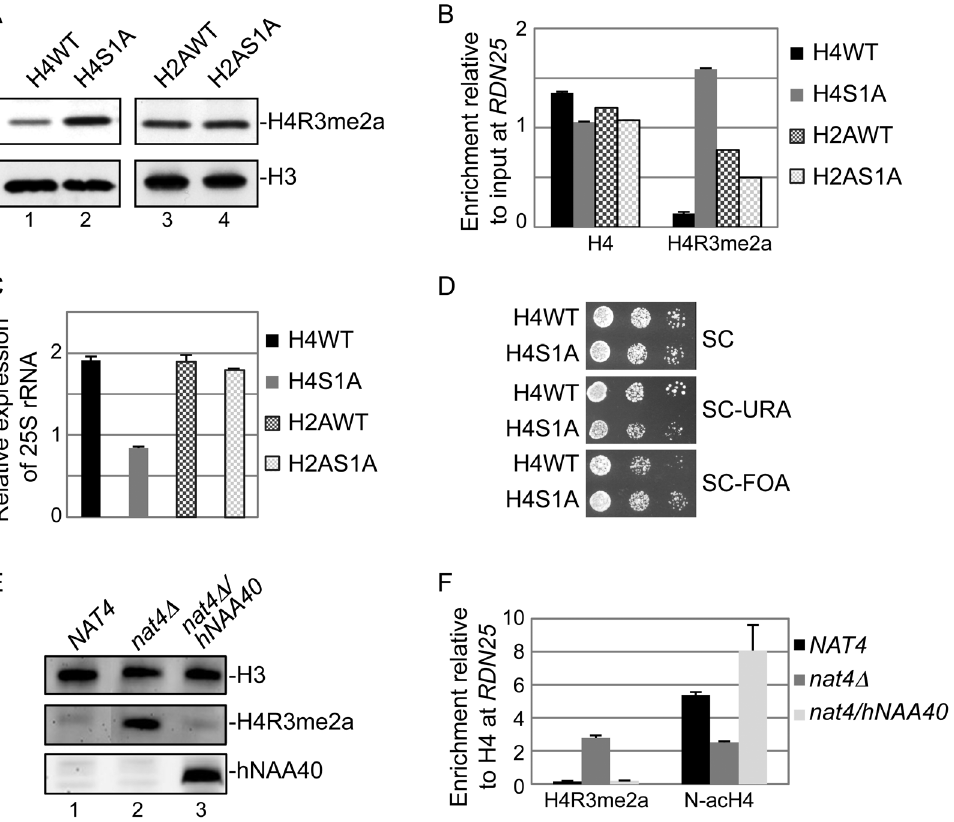
Figure 3. Nat4 inhibits rDNA silencing and H4R3me2a through N-terminal acetylation of H4. (A) Whole cell extracts prepared from the wild-type strains (H4WT and H2AWT) and their correspondent Serine-to-Alanine mutants in position 1 (H4S1A and H2AS1A) were analyzed by western blotting using antibodies against H4R3me2a (top panel) and H3 as control (bottom panel). (B) ChIP experiments were performed in the same strains as in (A) using the H4 and H4R3me2a antibodies. The immunoprecipitated chromatin was analyzed by qRT-PCR using primer I specific to the RDN25 gene (shown in figure 2C). The enrichment from each antibody was normalized to 1% of the total input DNA. (C) Gene expression analysis of 25S rRNA performed using the same strains as in (A) . The expression levels of the 25S rRNA were normalized to the levels of RPP0 . (D) Silencing